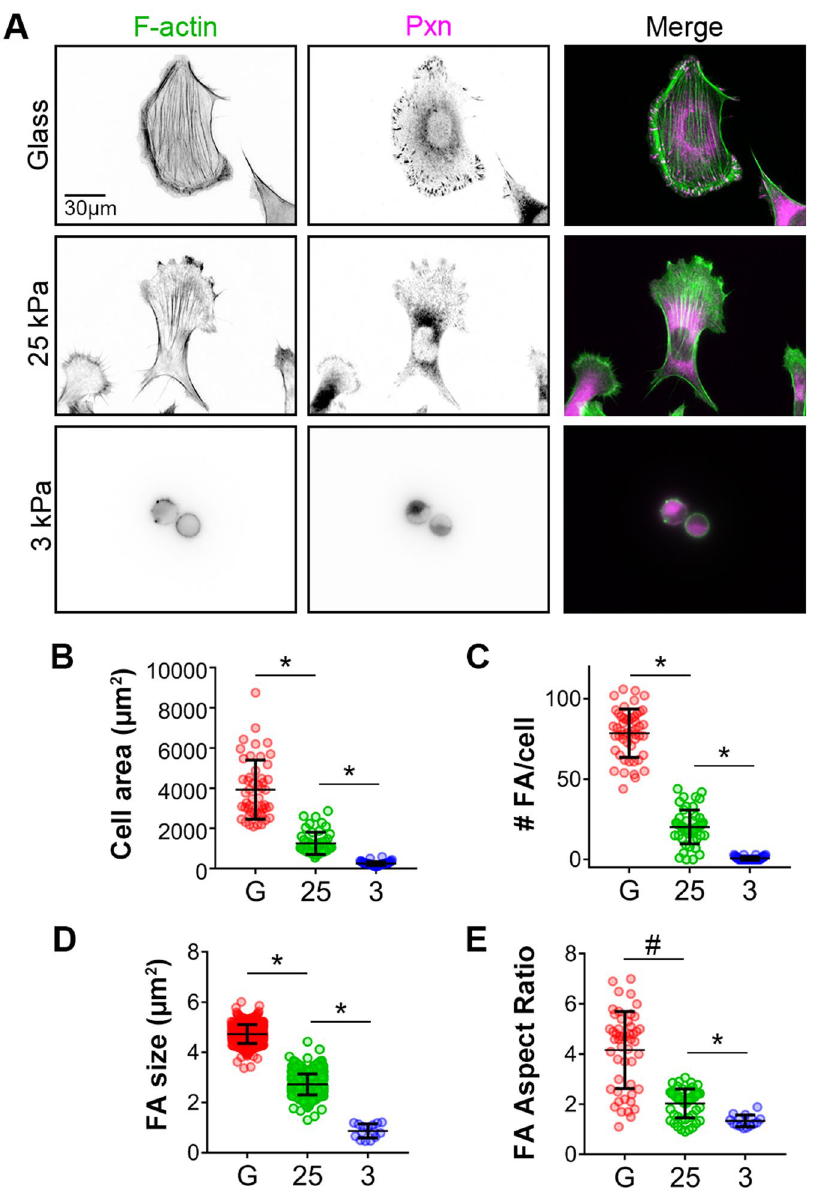
Figure 2. Cell size and focal adhesion morphology positively correlate with substrate rigidity. ( A ) SKOV-3 cells plated on FN-coated glass (top), 25 kPa, and 3 kPa hydrogels (middle and bottom) were fixed and stained with phalloidin and paxillin (Pxn) antibody to visualize F-actin stress fibers and focal adhesion complexes (FA) respectively. ( B – E ) Immunofluorescence images were analyzed for cells on each substrate to determine cell size ( B ), number of FA/cells ( C ), FA size ( D ), and FA aspect ratio ( E ). Graphs show all measured values as colored symbols as well as mean values ± s.d. as black bars (n = 50 cells ( B and C ) and 750 FA each for glass and 25 kPa and 15 FA for 3 kPa ( C and D ); * p < 0.0001 and # p = 0.0261, using the Mann-Whitney